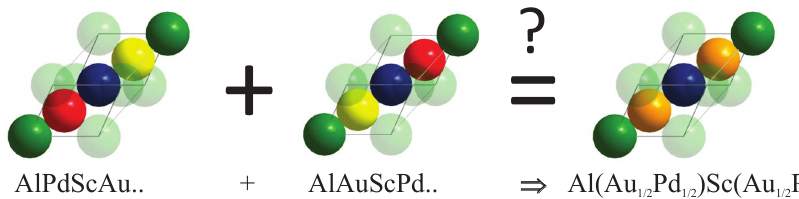
Figure 8. Coherent potential approximation (CPA) scheme from ordered to disordered AuPdScAl along (111) direction. The series of atoms corresponds to the arrangement of atoms along the [111] direction of the primitive fcc cell, which consists of the Wyckoff positions 4a (0,0,0), 4c (1/4,1/4,1/4), 4b (1/2,1/2,1/2), and 4d (3/4,3/4,3/4) of space group F 43 m . (also compare Figure